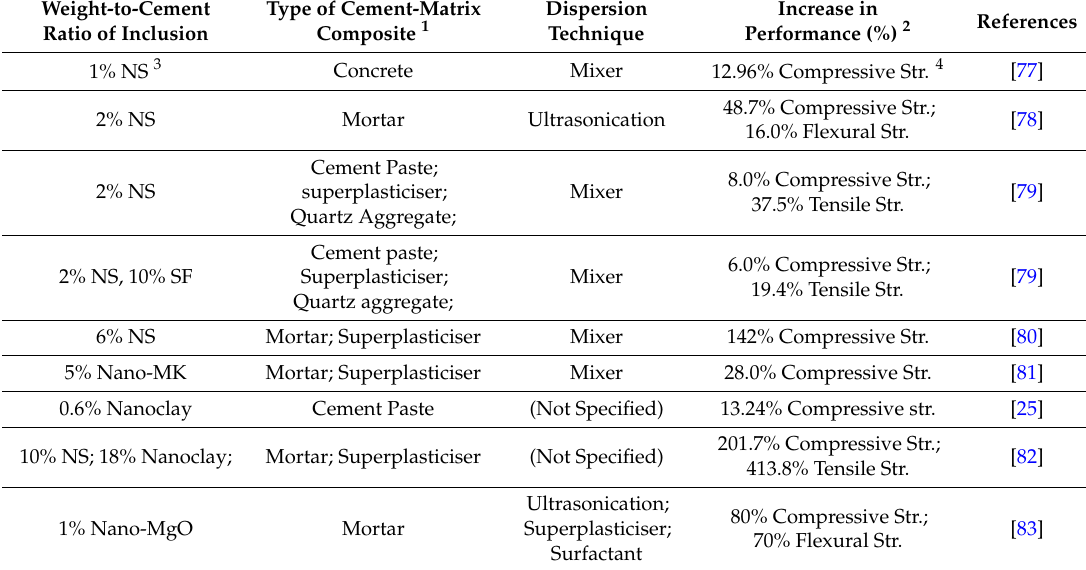
Table 1. Findings on the enhancement of the mechanical properties of cement-matrix